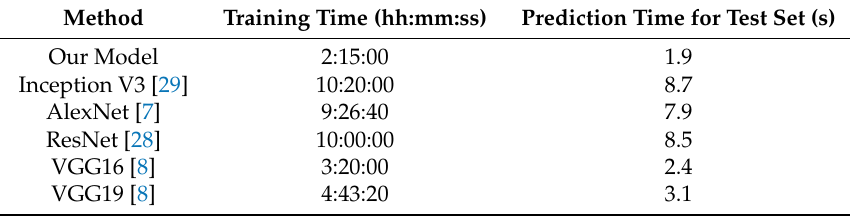
Table 7. Comparing the time required for training and